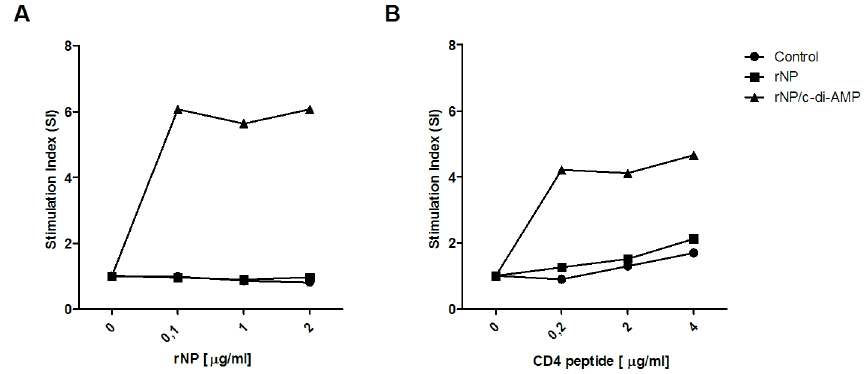
Figure 4. Analysis of proliferative responses in vaccinated mice. Splenocytes from immunized groups of mice were re-stimulated for 96 h with different concentrations of rNP (A) or a pool of peptides encompassing a MHC class II restricted epitopes of NP. Cellular proliferation was measured by incorporation of [ 3 H] thymidine into the DNA. The results are represented as stimulation index (SI).